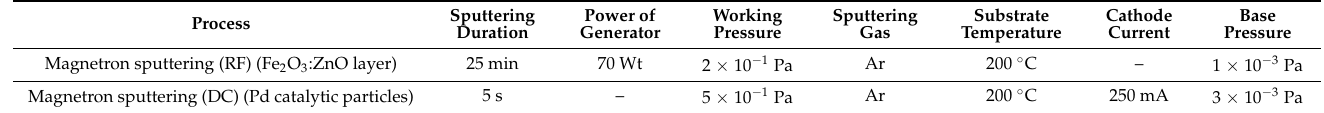
Figure 2. Schematic block diagram of the HPV sensor fabrication. Table 1. The deposition regimes of the Fe 2 O 3 :ZnO based thin layer and the Pd catalytic particles.